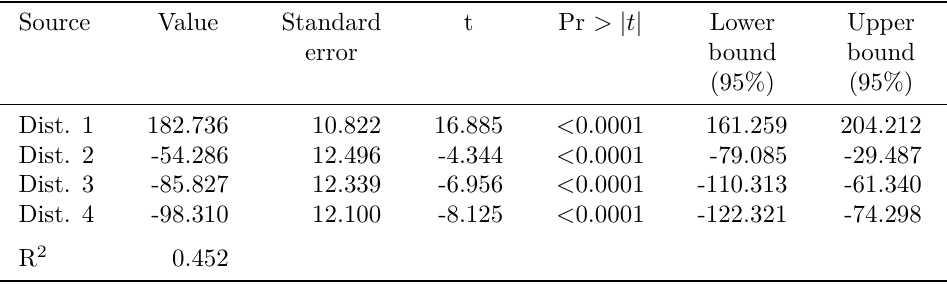
Table 3: General estimation results (Model